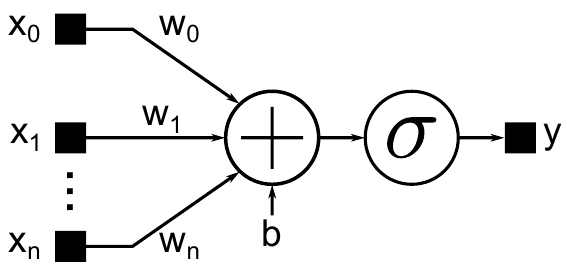
Figure 3. A graphical model of the